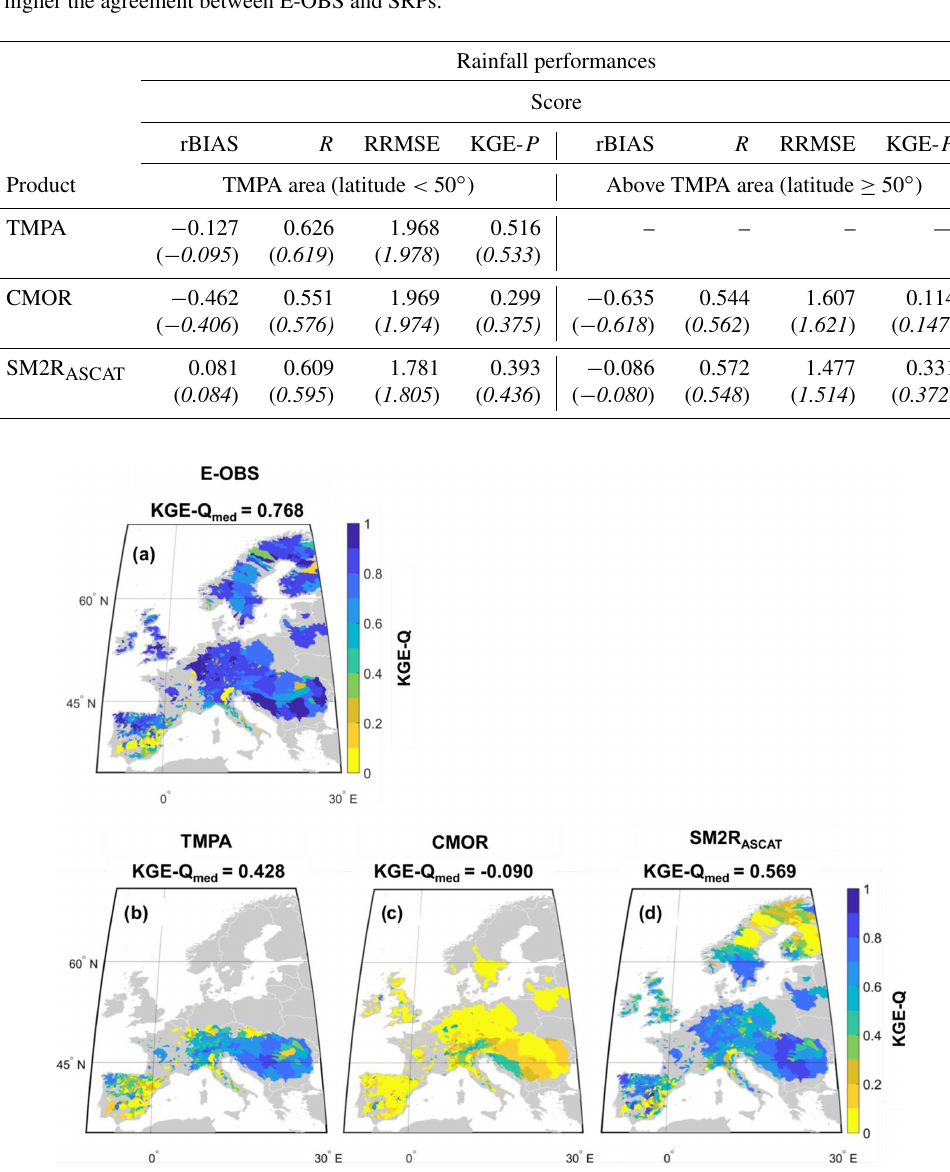
Figure 3. Maps of the KGE- Q index obtained by considering (a) E-OBS, (b) TMPA, (c) CMOR and (d) SM2R ASCAT rainfall data sets. For E-OBS, the KGE- Q index has been obtained by comparing observed against modelled discharge data over the period 2007–2016. Modelled discharge data have been obtained by using the E-OBS rainfall data set as input to the MISDc model. For the satellite data, KGE- Q refers to the validation period (2013–2016). In panels (a) , (b) , (c) and (d) , the median KGE value averaged over the original product coverage is